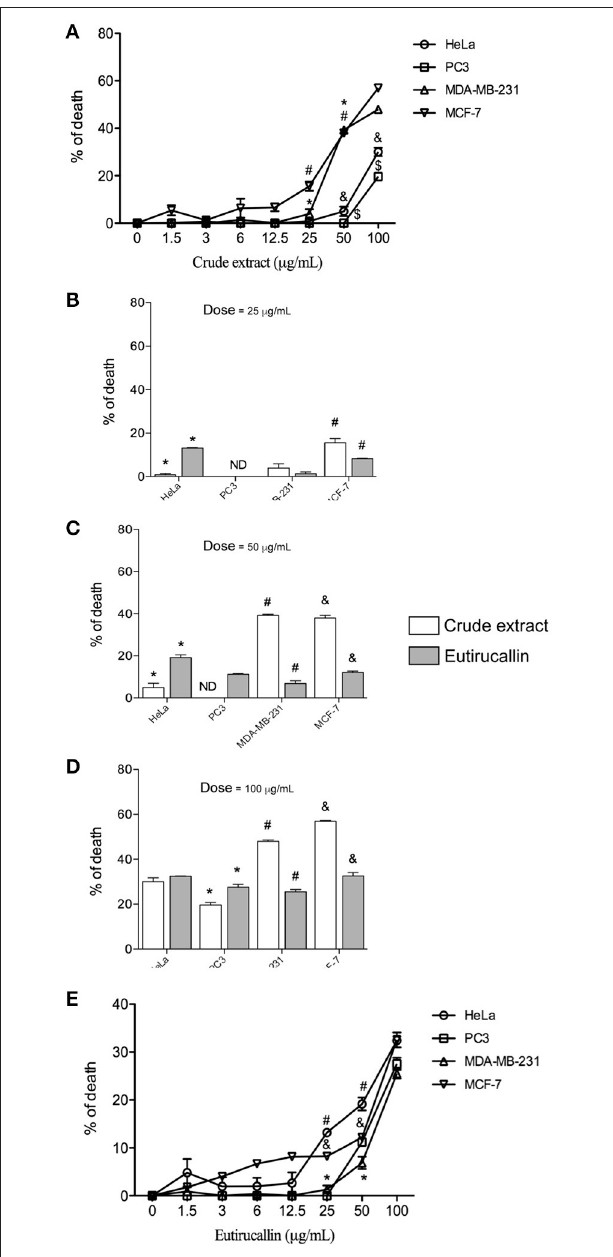
FIGURE 4 | Antitumor activity of crude extract and Eutirucallin against HeLa, PC3, MDA-MB-231, and MCF-7. (A,E) Cell viability assayed by MTT showing that the cytotoxic effects of crude extract and Eutirucallin start at 25 µ g/mL. Bars represent standard errors; * , # , & , $ P < 0.05 compared to 25 µ g/mL. (B–D) Percentage of death results showed that breast cancer cell lines (MDA-MB-231 and MCF-7) are more sensitive to crude extracts and PC3 and HeLa are more sensitive to Eutirucallin cytotoxic effects. PC3 is the most resistant cell to the harmful effects of crude extract and Eutirucallin. Bars represent standard errors; * , # , & P < 0.05 between groups.